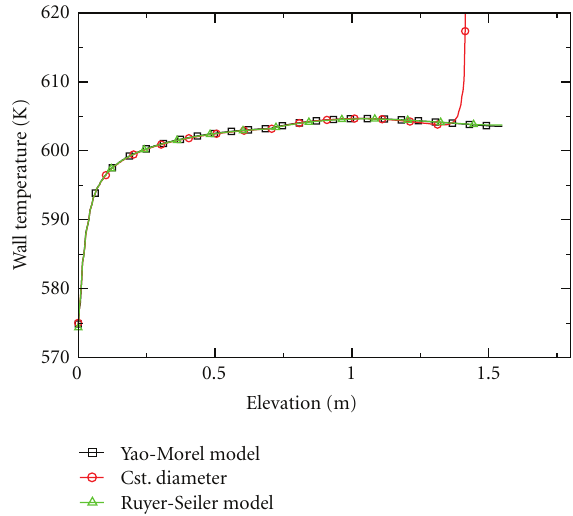
Figure 19: Evolution of the wall temperature at the probe position for di ff erent bubble-size